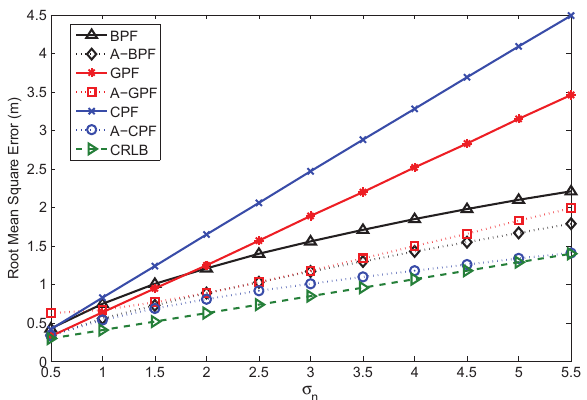
Figure 9. Comparing the performances of different